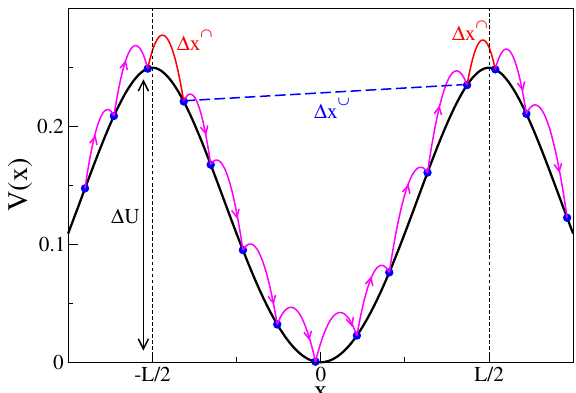
Figure 1: Schematic representation of the dynamics of Il’in Khasminskii (IK). Each arc rep- resents the deterministic trajectory in between two successive collisions with the heat bath. External flights (red) connect different potential wells, while internal flights (blue) connects two successive external flights. The curvatures of the potential at the top and at the bottom of the barrier are respectively ω 2